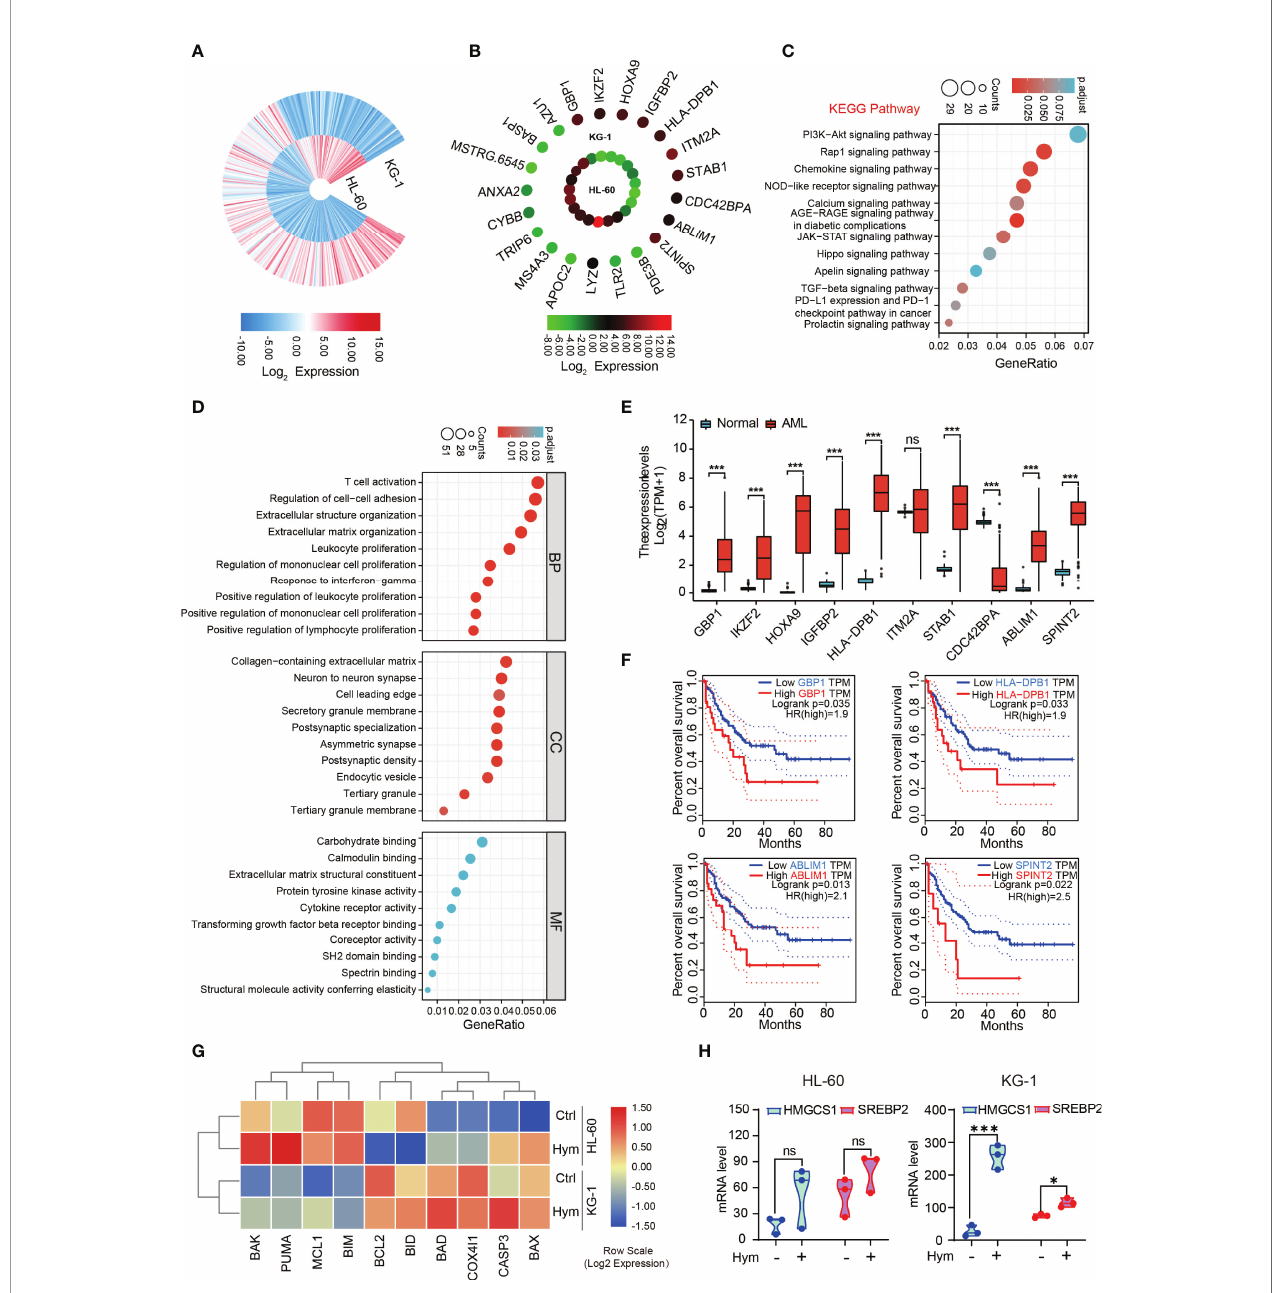
FIGURE 6 | Comparison of transcriptomic pro fi les between HL-60 and KG-1 cells. (A) The gene expression differences between HL-60 and KG-1 cells resulted from analysis of RNA-seq. (B) The top ranked 20 genes with the highest differential expression level between HL-60 and KG-1 cells. (C, D) Functional enrichment analyses by KEGG (C) and GO (D) . The top ten terms in each analysis were listed. The color of the dot represents adjusted p-value. Size of the dot represents the number of genes associated with each term. (E) The expression discrepancy of the top 10 differentially expressed genes with high level in KG-1 cells between AML and normal controls. (F) The in fl uence of GBP1, HLA-DBP1, ABLIM1, and SPINT2 expression on OS in AML. (G) The heatmap of apoptosis related genes expressions after hymeglusin treatment, revealed by RNA-seq. (H) The alterations of HMGCS1 and SREBP2 expressions after hymeglusin treatment, revealed by RNA-seq. *P<0.05, ***P<0.001. ns, not signi fi